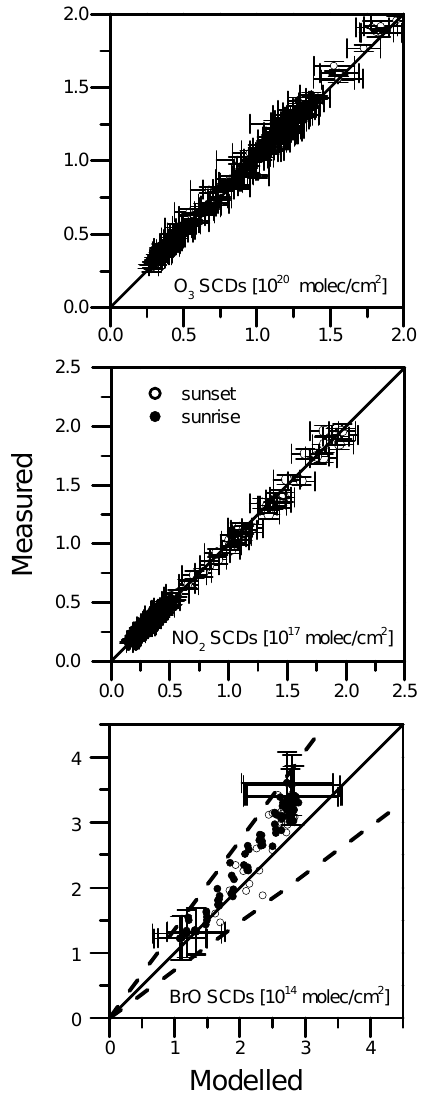
Fig. 4. Inter-comparison of limb measured versus modelled slant column concentrations of O 3 (upper panel), NO 2 (middle panel) and BrO (lower panel) for the standard JPL-2011 kinetics in units as given in the panels. Due to the scaling the slant column densities of O 3 and NO 2 excellently agree, but only fair agreement is obtained for BrO with standard model parameters. In the lower panel the JPL- 2011 uncertainty of the J ( BrONO 2 )/k BrO + NO ratio is indicated 2 (dashed